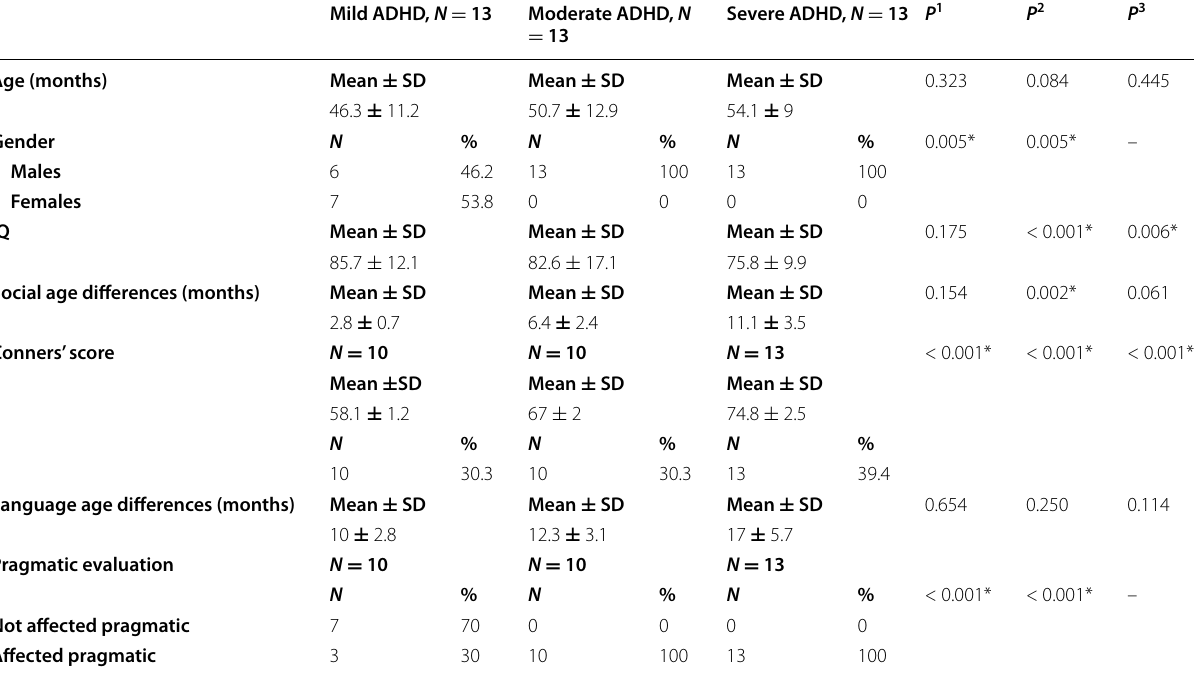
Table 2 Descriptive and comparative analysis of demographic data and psychometric and communicative evaluation among the ADHD